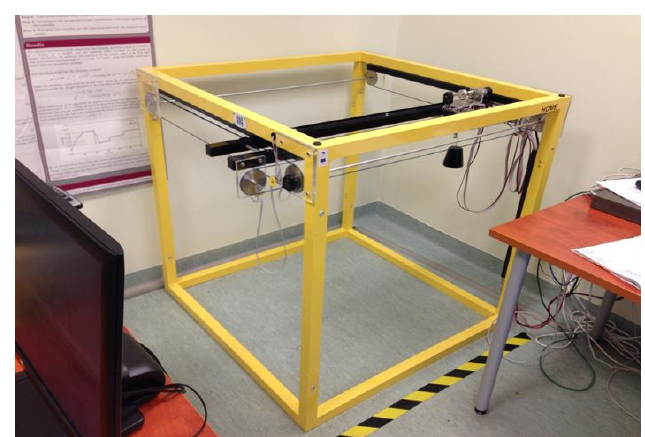
Fig. 1. Laboratory 3D Crane setup.